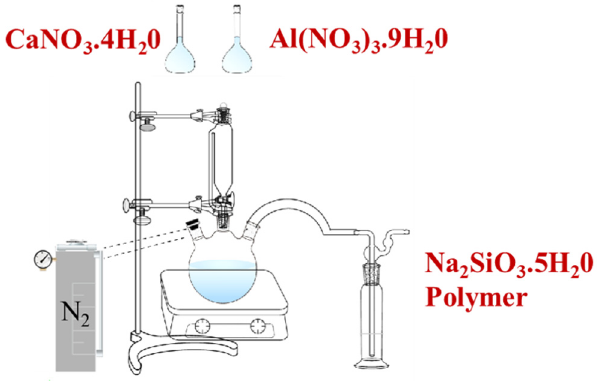
Figure 3. The preparation scheme of polymer/C ‐ A ‐ S ‐ H composite samples.